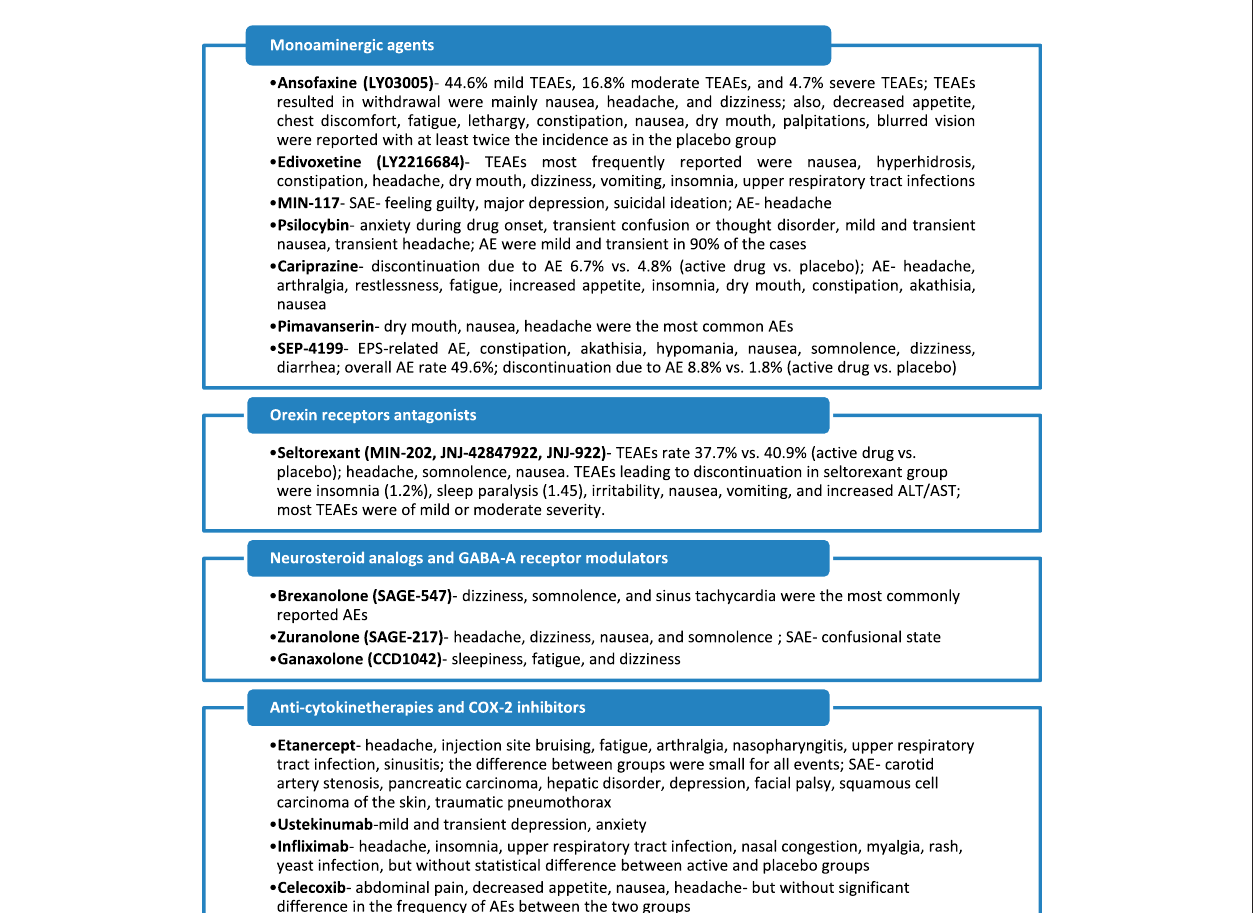
FIGURE3| Mainadverse eventsreportedinclinicaltrialsforinvestigationalantidepressants. TEAE,treatment-emergentadverse events;AE,adverseevents;SAE, severe adverse events; EPS, extrapyramidal symptoms. BasedonthedatafromMietal.,2021;Balletal.,2015;Carhart-Harrisetal.,2016;COMPASS,2021;Citrome,2019; Favaetal.,2018;Durgametal.,2016;Favaetal.,2019;Loebeletal.,2022;Savitzetal.,2021;KanesS.etal.,2017;Gunduz-Bruceetal.,2019;Deligiannidisetal.,2021;Dichteletal., 2020; Tyring et al., 2006; Langley et al., 2010; Raison et al., 2013; Abbasi et al., 2012.